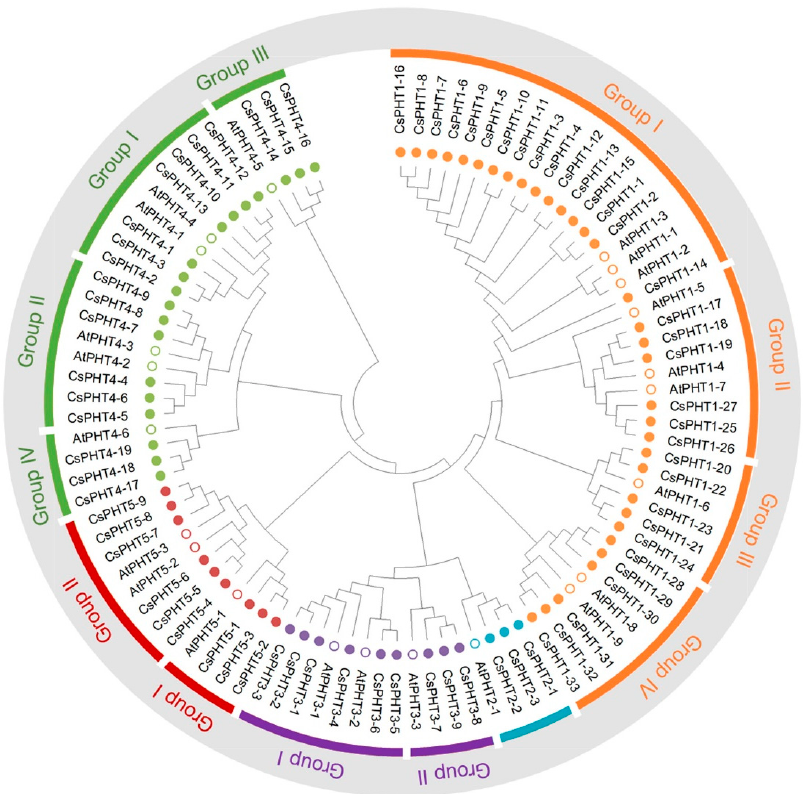
Figure 1. Evolutionary relationship between Camelina and Arabidopsis phosphate transporters